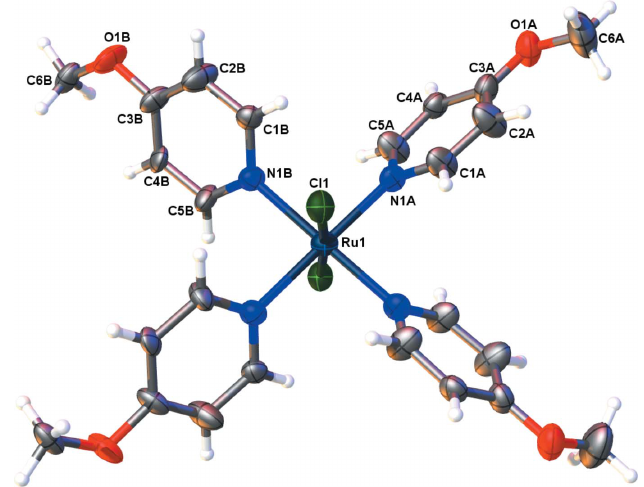
Figure 1 Displacement ellipsoid (50% probability level) representation of the title complex with disorder omitted for